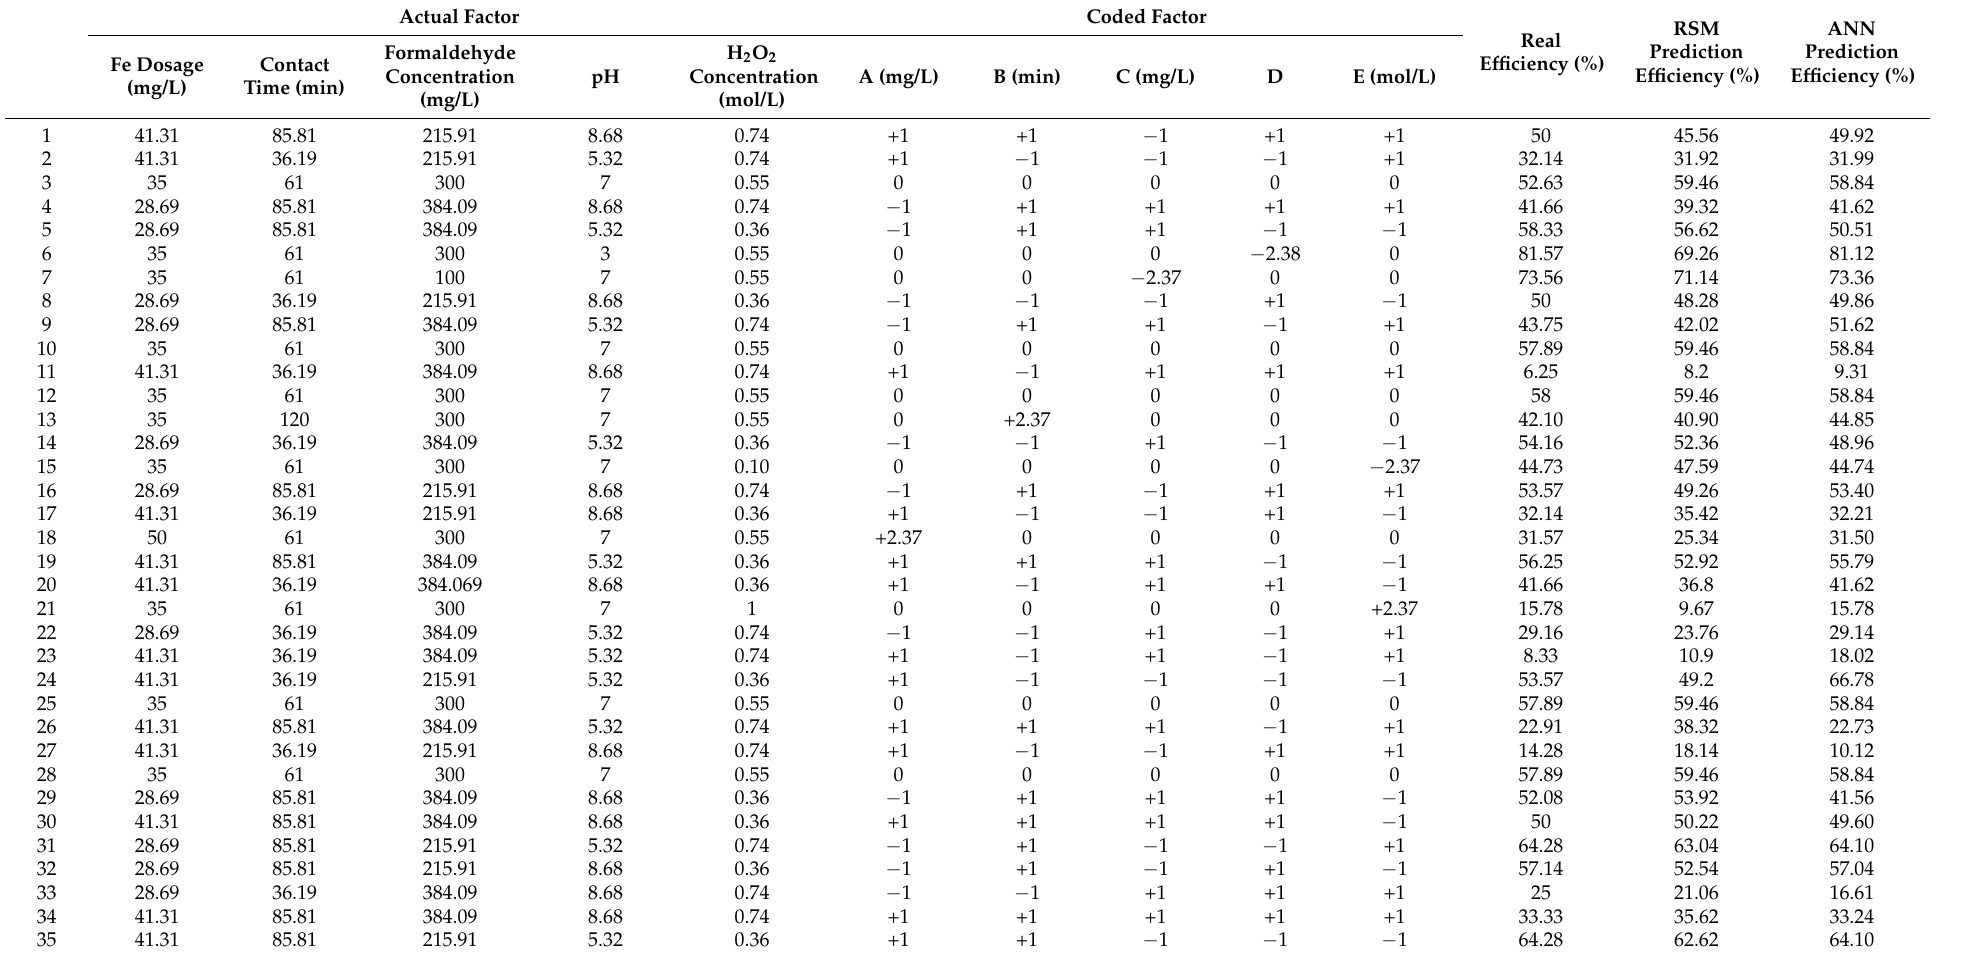
Table 3. The design matrix and the experimental vs. predicted results for the elimination of FA from aqueous solutions using the Fenton